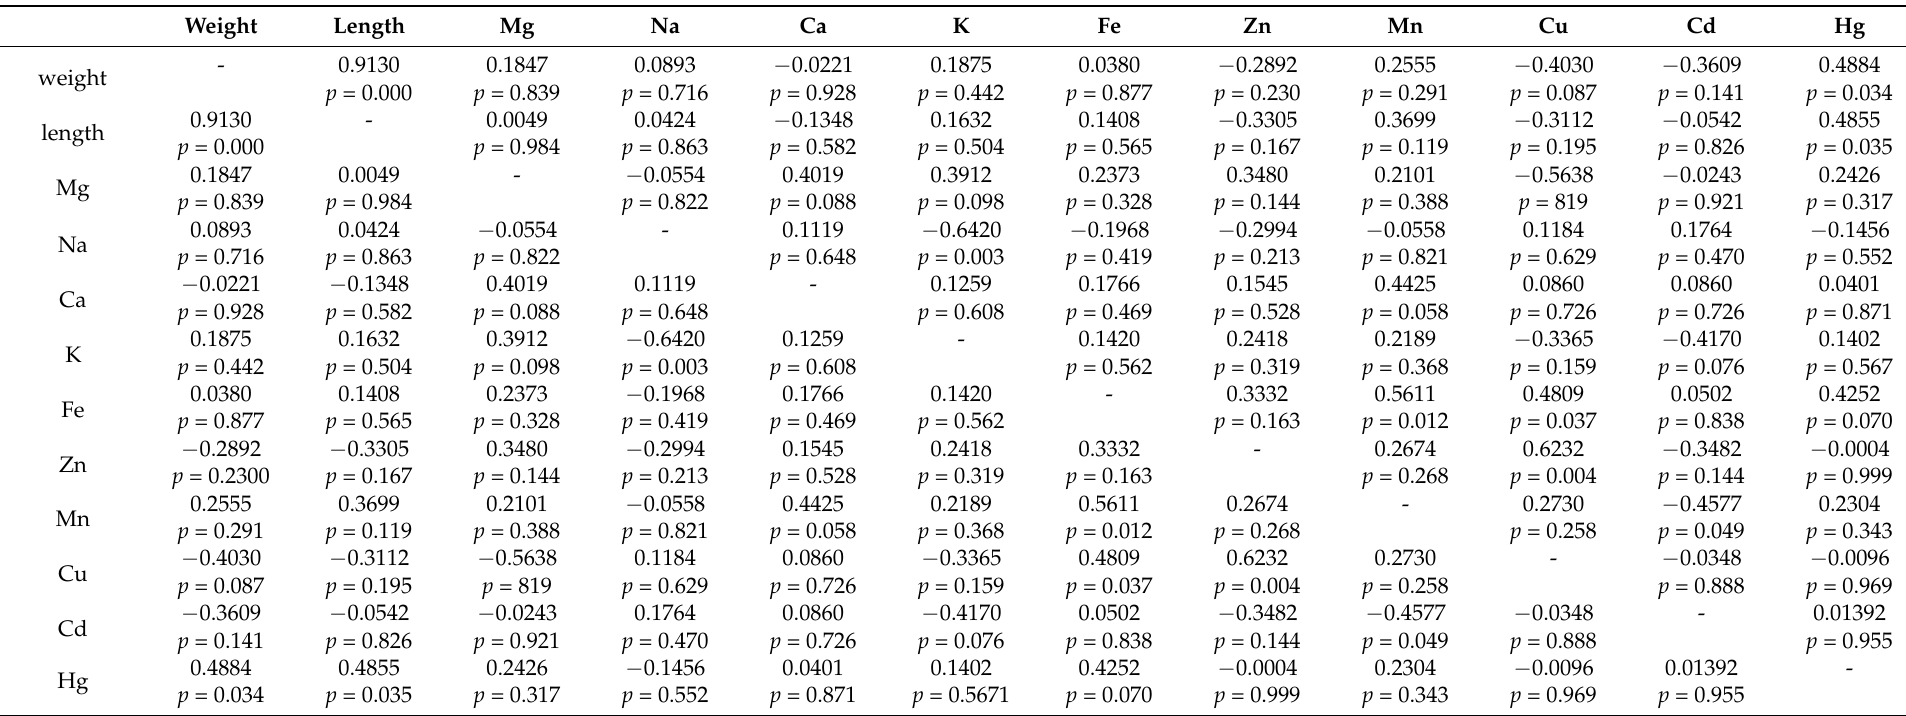
Table 1. Linear correlation coefficients (r) between metal content in the muscles of eels ( Anguilla anguilla L.) and body weight or total